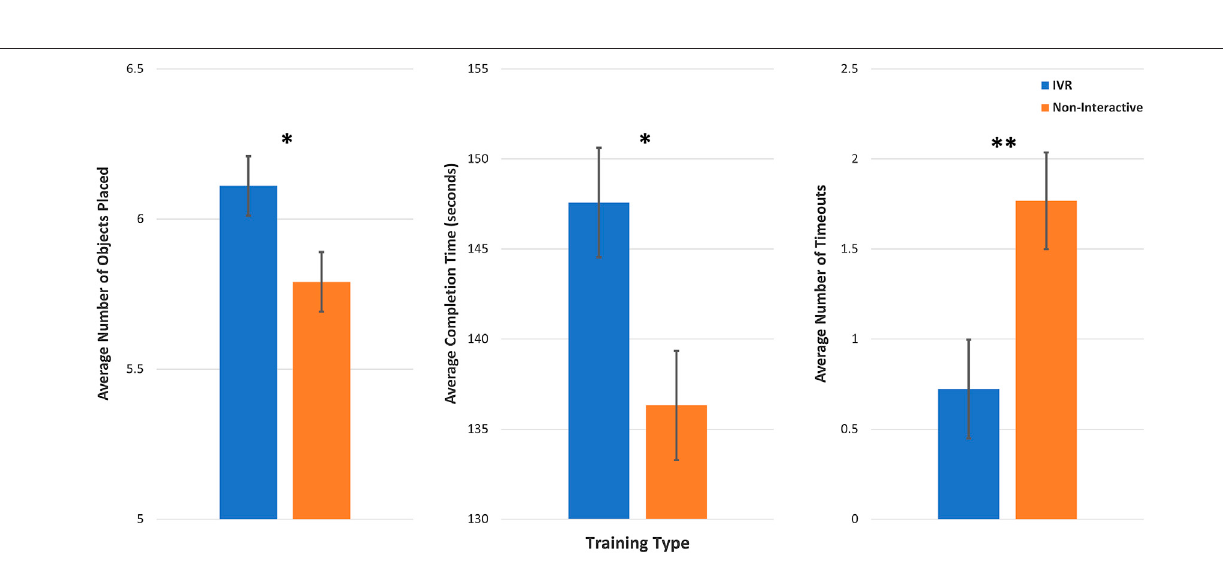
Frontiers in Virtual Reality |